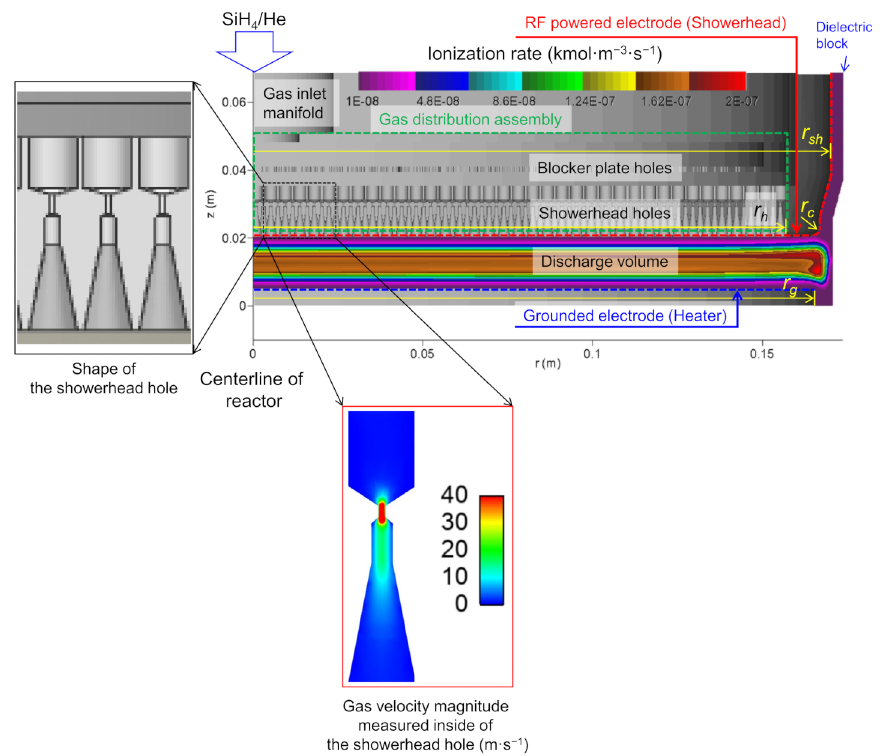
Figure 1. CCP reactor configuration plotted together with the spatial variation of the time-averaged ionization rate (kmol · m − 3 · s − 1 ). The magnitude of the gas velocity measured inside the showerhead hole is shown. The reactor dimensions are also